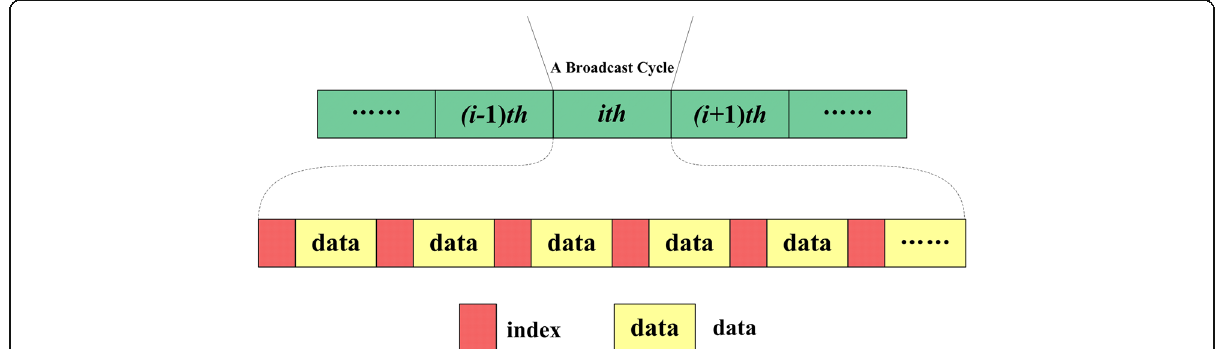
Fig. 1 (1, m) index scheme. The (1, m) index scheme makes the index for all of the data items allocated m times preceding each 1/ m fraction of data items on the wireless